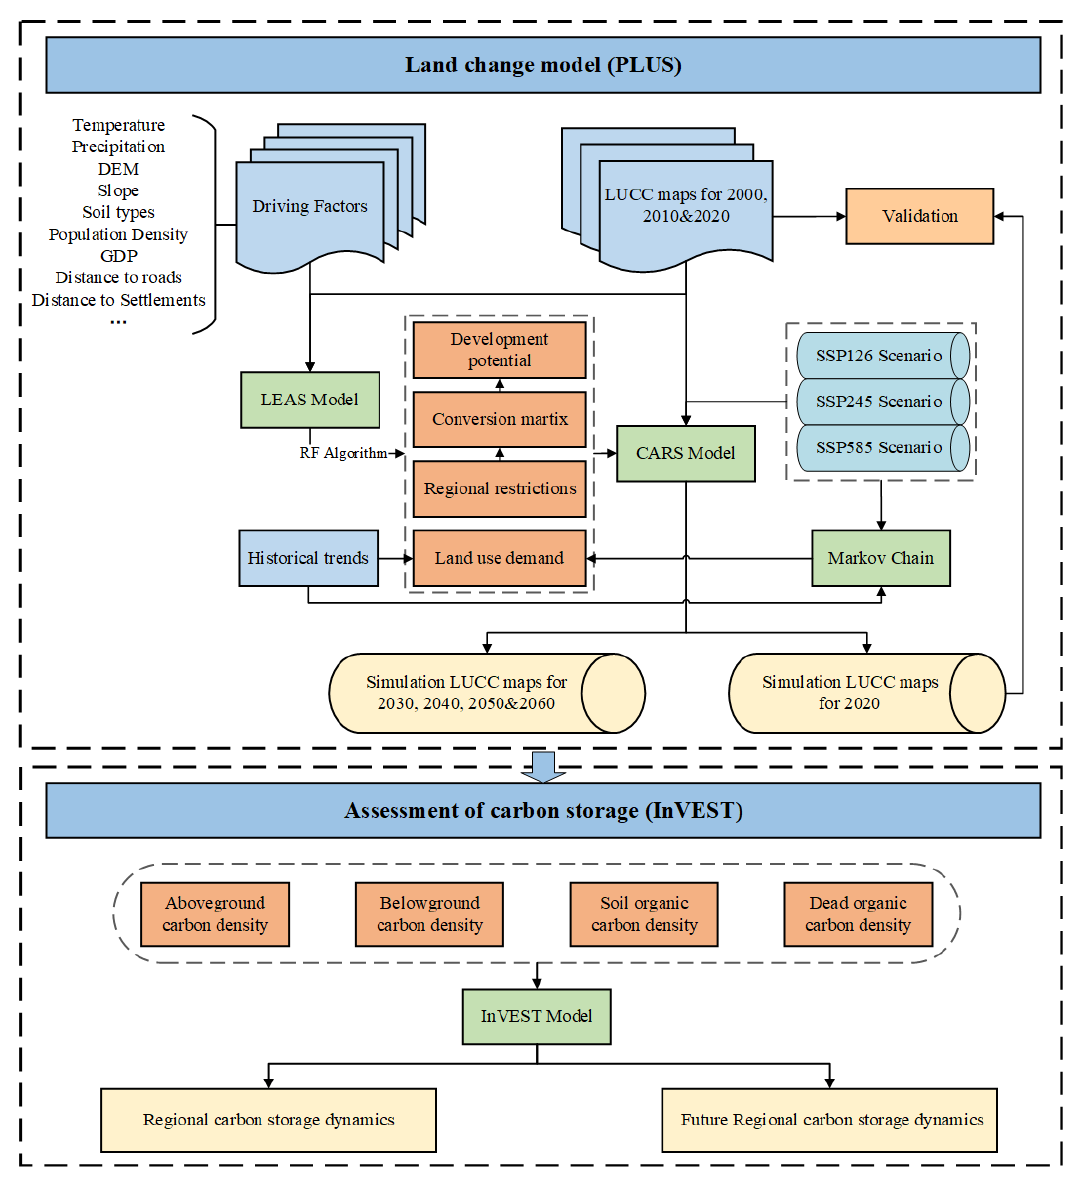
Figure 2. Research framework.